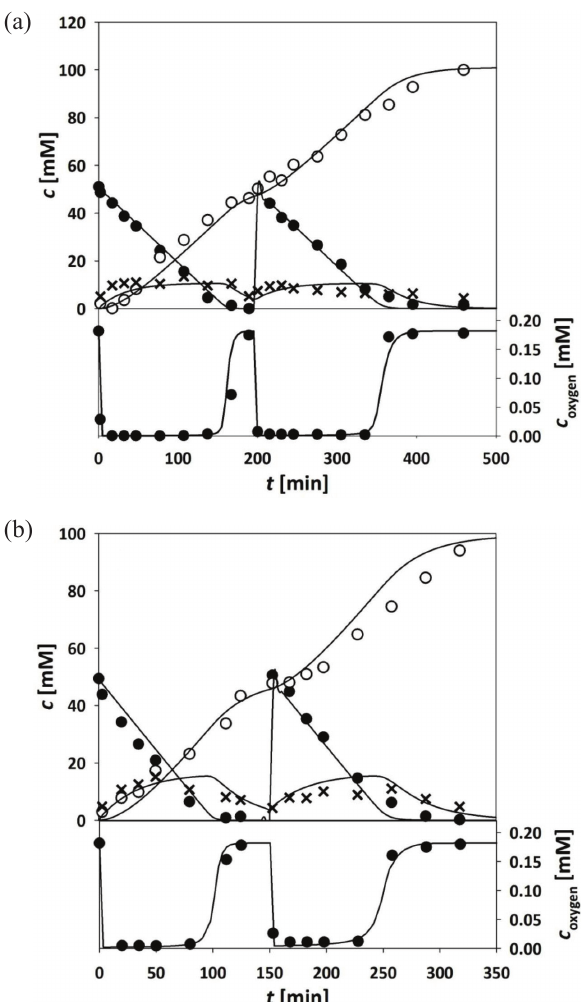
Fig. 6 – Glucose oxidation catalysed by free GOD from As- pergillus niger in the batch reactor (c = 50 mM, γ = glucose0 free GOD 0.04 mg cm –3 , φ = 0.002, 0.1 M phosphate buffer pH = 7; catalase 30 °C; V = 50 cm 3 ) at the aeration level of: a) 15 dm 3 h –1 b) reactor 30 dm 3 h –1 (upper graph: black circle – glucose, white circles –gluconic acid, x – glucono-δ-lactone; bottom graph – oxygen).